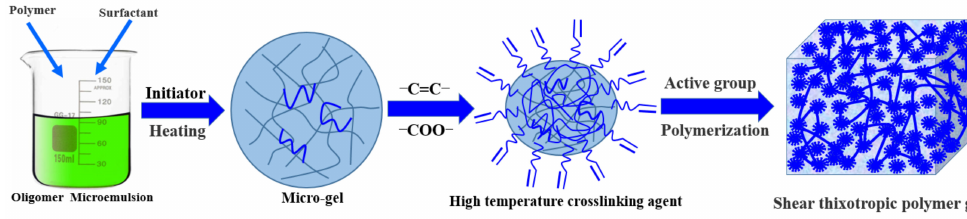
Figure 11. High temperature resistance mechanism of shear thixotropic polymer